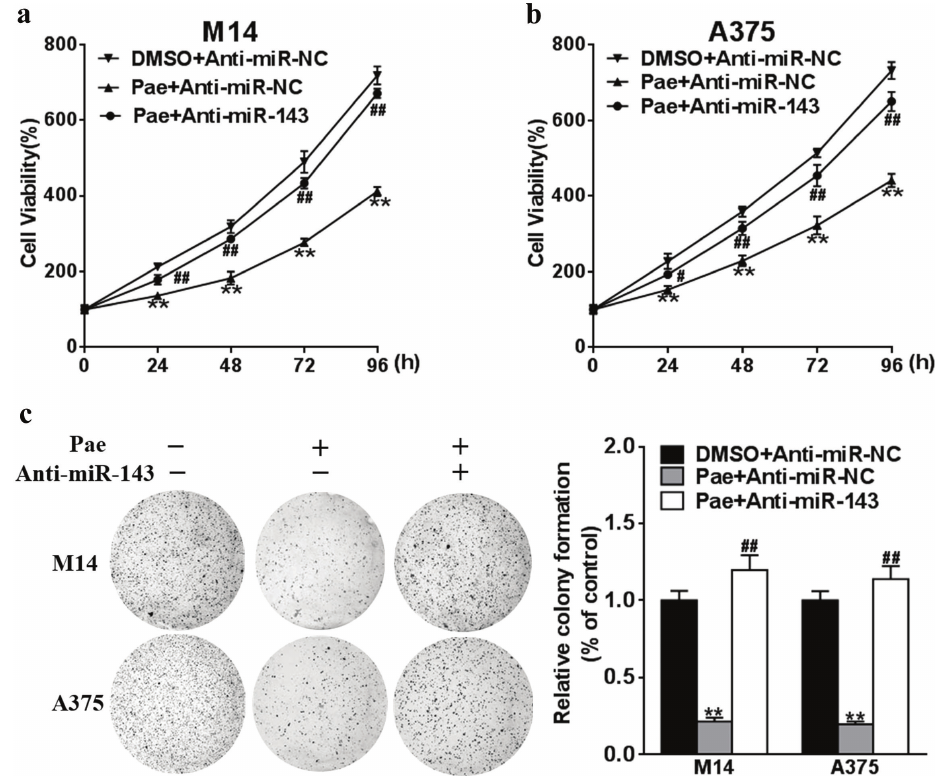
Fig. 3 . Silence of miR-143 reverses the adverse effect of paeonol (Pae) on melanoma. M14 and A375 melanoma cells were trans- fected with Anti-miR-143 or Anti-miR-NC, and were treated with 500 μM Pae or DMSO. (a, b) CCK-8 assay was used to test cell proliferation. (c) Colony formation assay was employed to analyze the cell growth ability. ** P < 0.01 versus DMSO+An- ti-miR-NC group. ## P < 0.01 versus